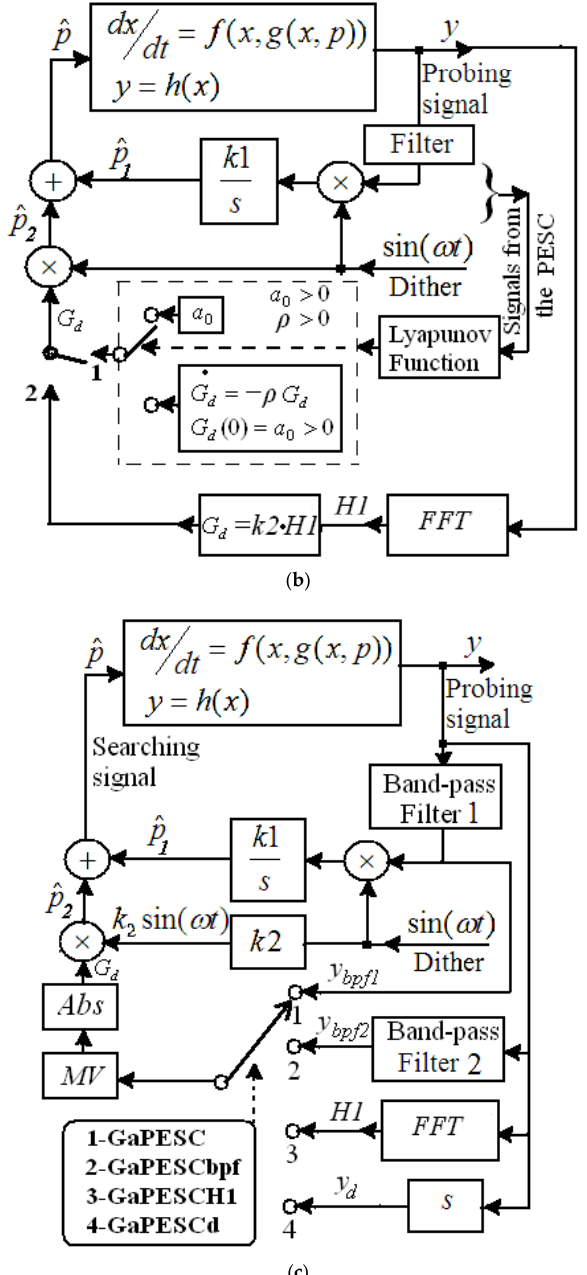
Figure 1. aPESC, modified aPESC and Global aPESC schemes. ( a ) The scalar PESC (PESCs) scheme and its asymptotic variant (aPESCs) with the swithch on the position 1 and 2; ( b ) Modified aPESC schemes. The aPESC schemes based on the Lyapunov finction (aPESCLyy) and the H1 harmonic (aPESCH1) with the switch on the position 1 and 2; ( c ) Global aPESC (GaPESC) schemes.